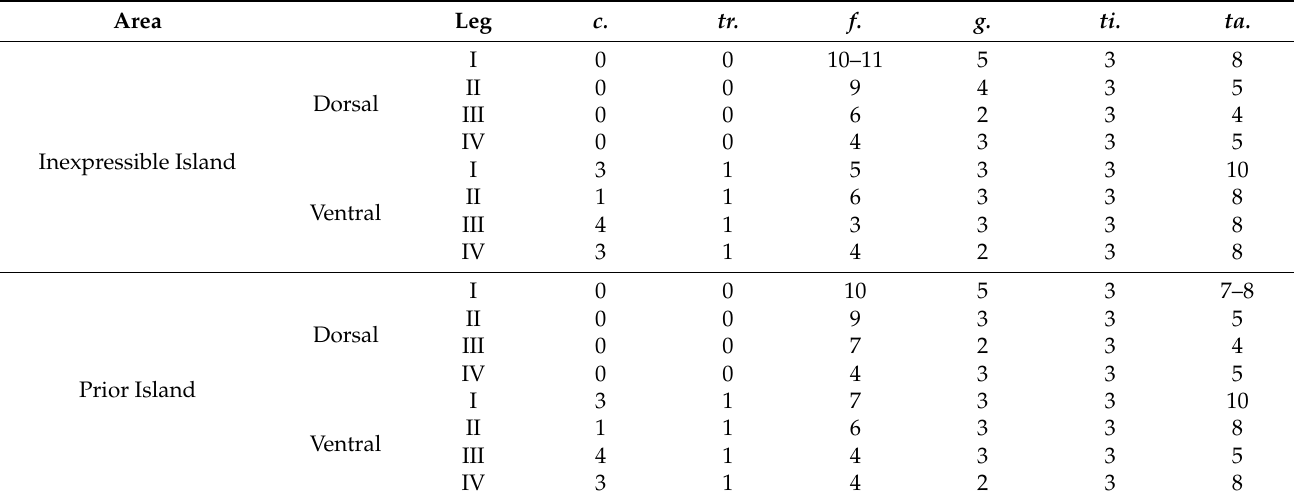
Table 2. Leg chaetotaxy of S. ineffabilis specimens from Inexpressible Island and Prior Island. Dorsal and ventral refer to surfaces of the leg segments; solenidia are excluded from the count while trichobothria are included (see Figures 3 and 4 for the details and position of leg chaetotaxy). c. coxa, tr. trochanter, f. femur, g. genu, ti. tibia and ta. tarsus. Area Leg c. tr. f. g. ti. ta.